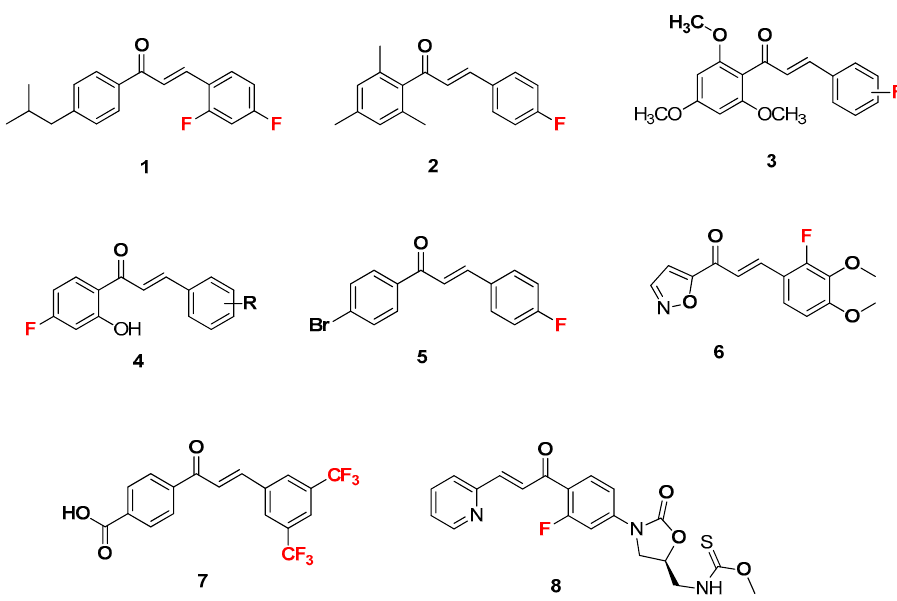
Figure 1. Structures of fluorinated chalcones with antibacterial and antifungal activities.